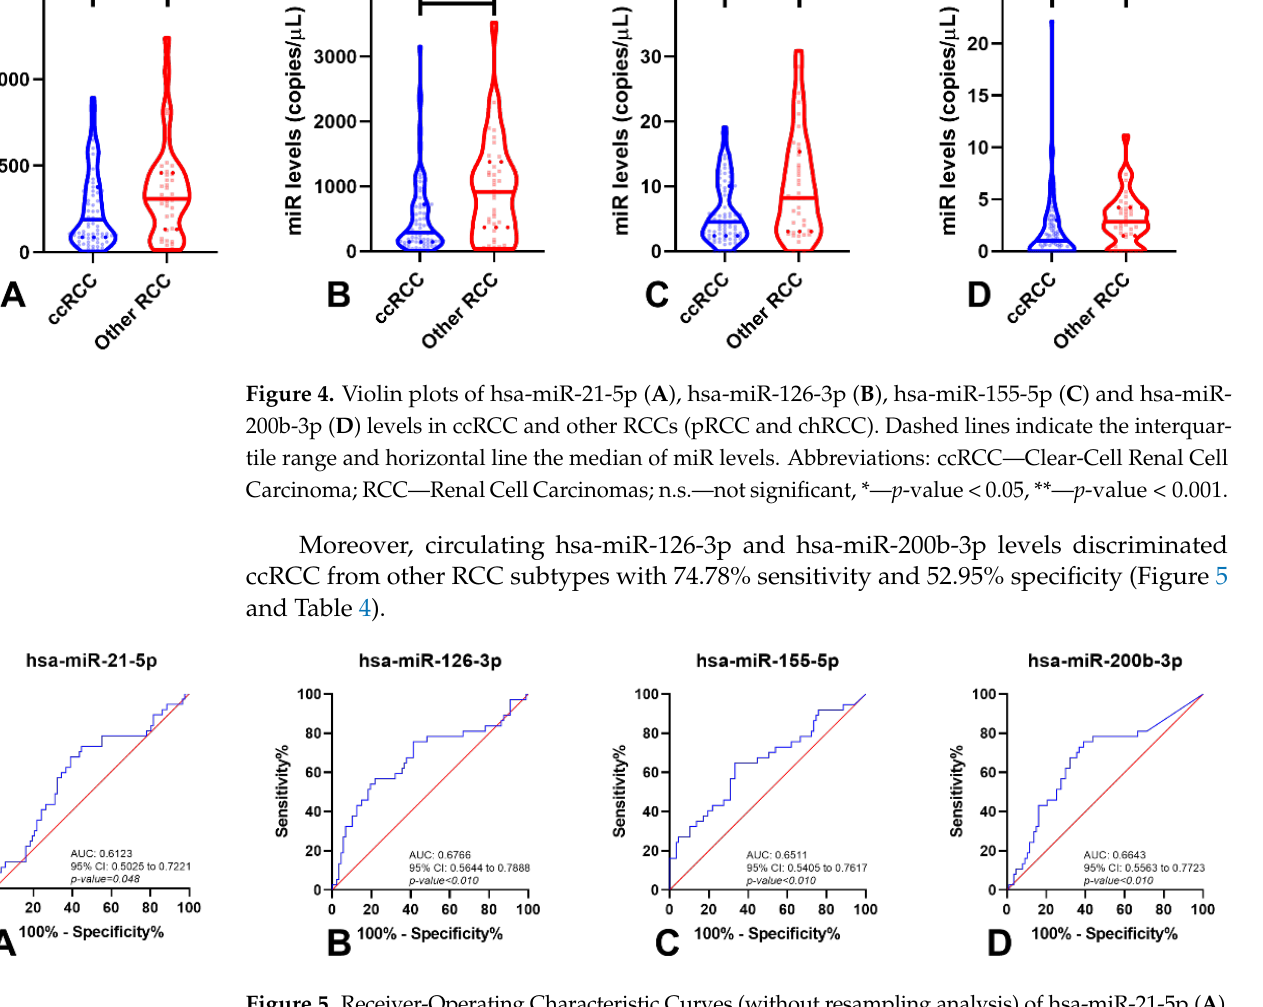
Figure 5. Receiver-Operating Characteristic Curves (without resampling analysis) of hsa-miR-21-5p ( A ), hsa-miR-126-3p ( B ), hsa-miR-155-5p ( C ) and hsa-miR-200b-3p ( D ) in ccRCC and other RCCs (pRCC and chRCC). Red line indicates the reference line and blue line the identity line for each miRNA. Table 4. Performance of miRNAs as biomarkers for identification of Clear-Cell Renal Cell Carci- noma.